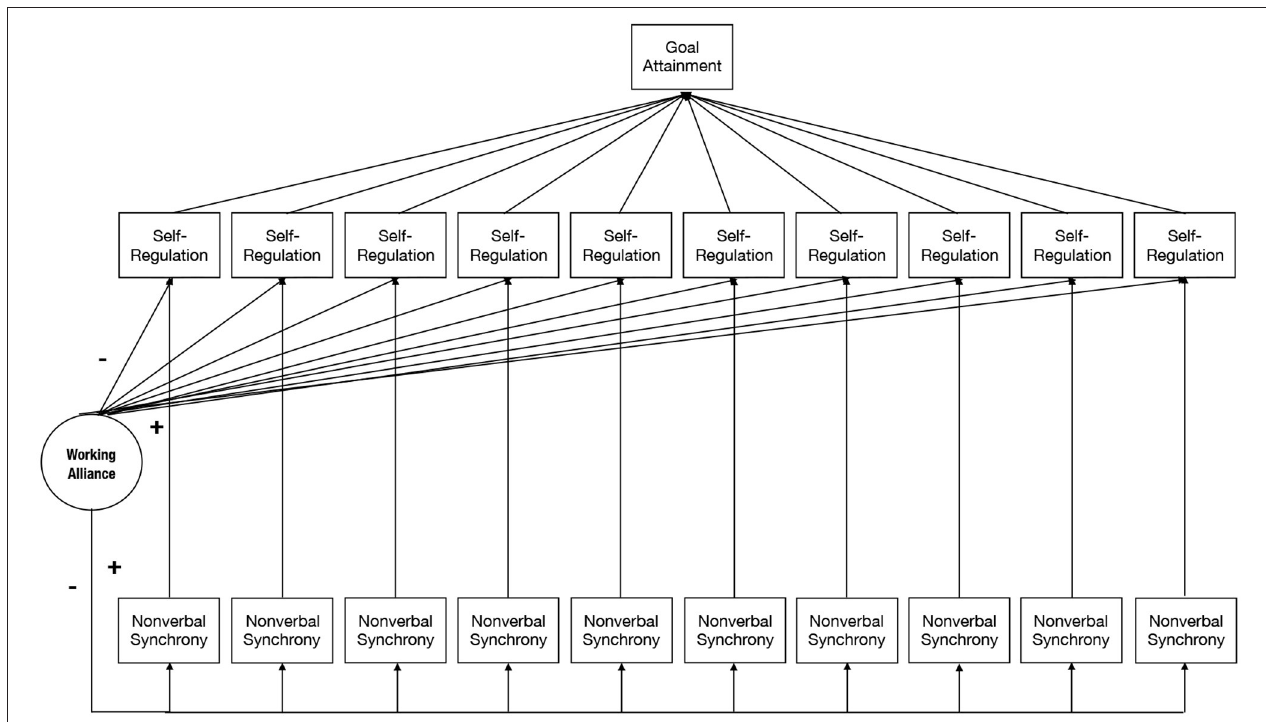
FIGURE 1 | Prediction Model. Prediction model, in which Nonverbal Synchrony represents nonverbal body responses in dyads as measured with MEA; Self-Regulation as measured through positive/negative affect; Working Alliance as measured through Working Alliance Inventory is predicted to moderate the relationship between Nonverbal Synchrony and Self-Regulation as a process. Goal attainment is measured through goal-directed behavior scales and is mediated via Self-Regulation as a